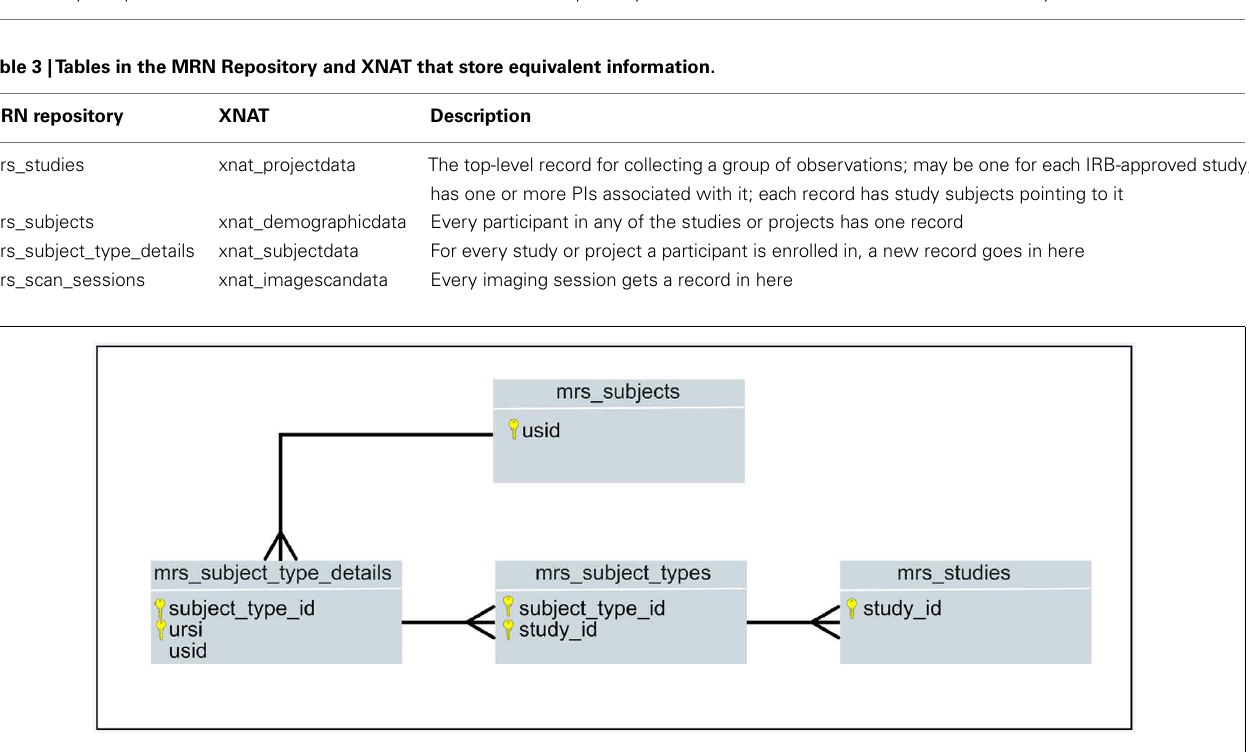
FIGURE 10 | Key-only, ER Diagram of a portion of MRN’s database: mrs_subject_types is used for tracking controls, withdrawn, excluded, patient, and other user-definable classes of a participant in a